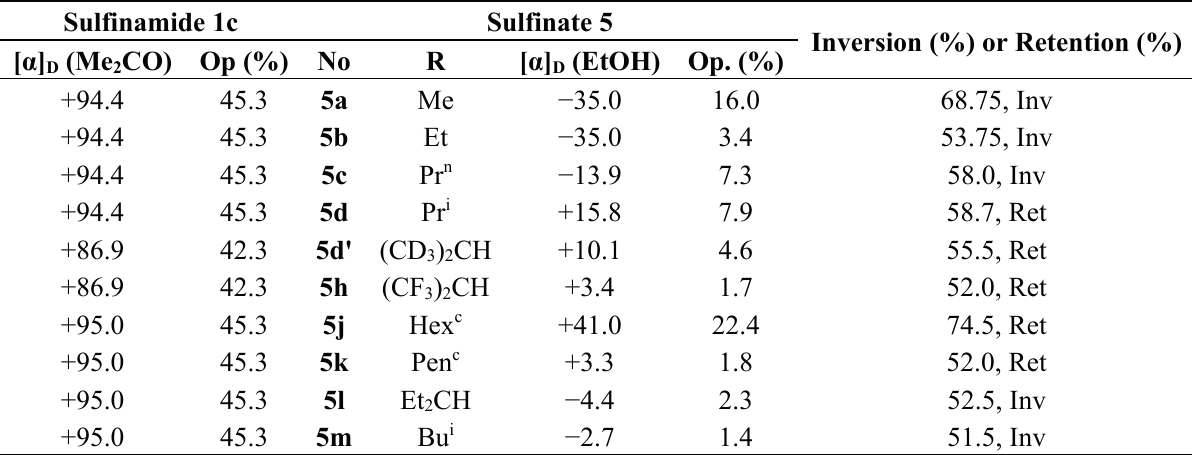
Table 3. Stereoselective synthesis of optically active O -alkyl p -toluenesulfinates ( 5 ), p -TolS(O)OR, from sulfinamide (+)-( S )- 1c using trifluoroacetic acid as catalyst. Sulfinamide 1c